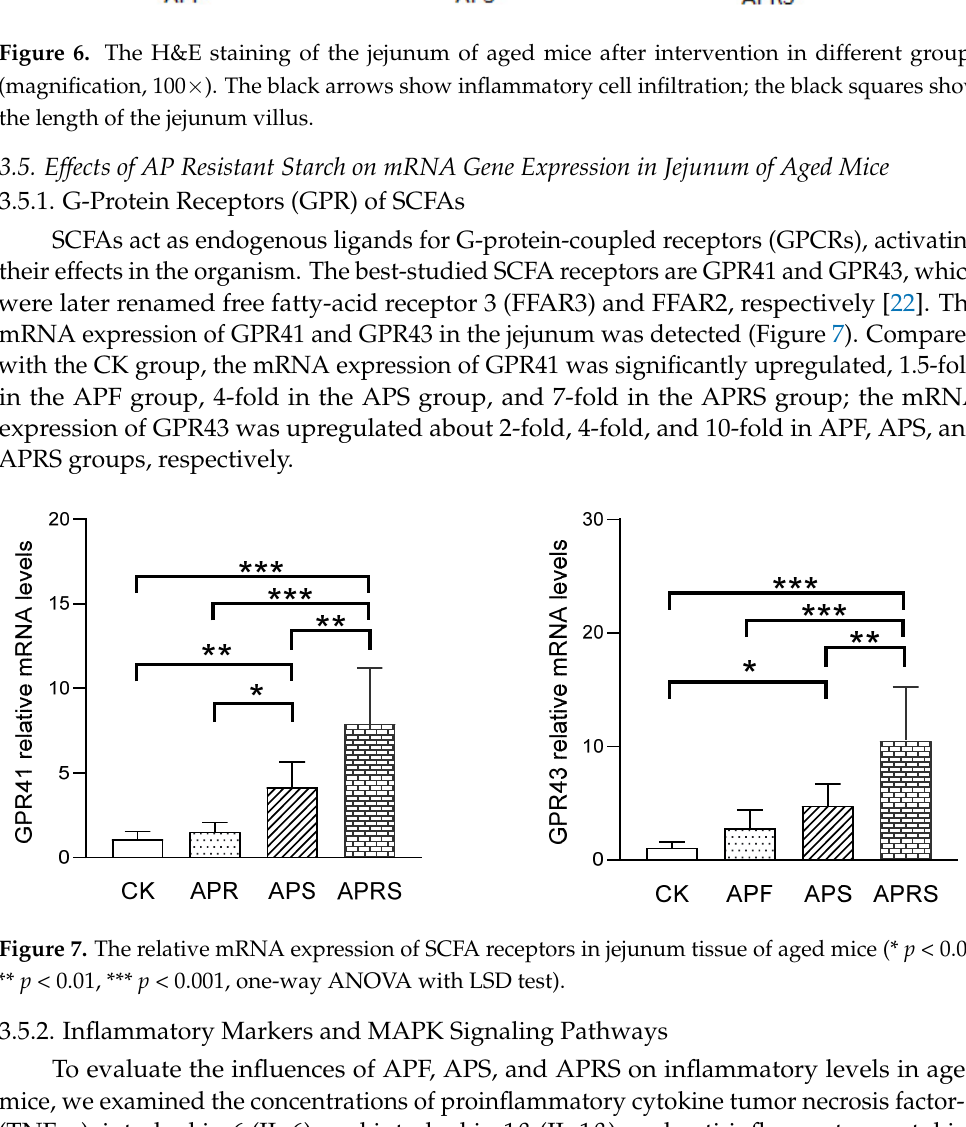
Figure 7. The relative mRNA expression of SCFA receptors in jejunum tissue of aged mice (* p < 0.05, ** p < 0.01, *** p < 0.001, one-way ANOVA with LSD test).